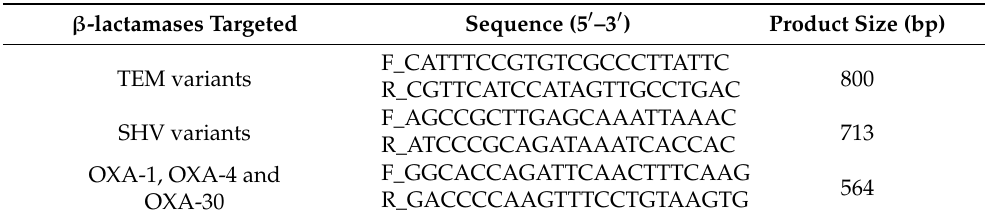
Table 1. Nucleotide sequences of the primers used for the amplification of bla TEM / bla SHV / bla OXA genes and size of the respective